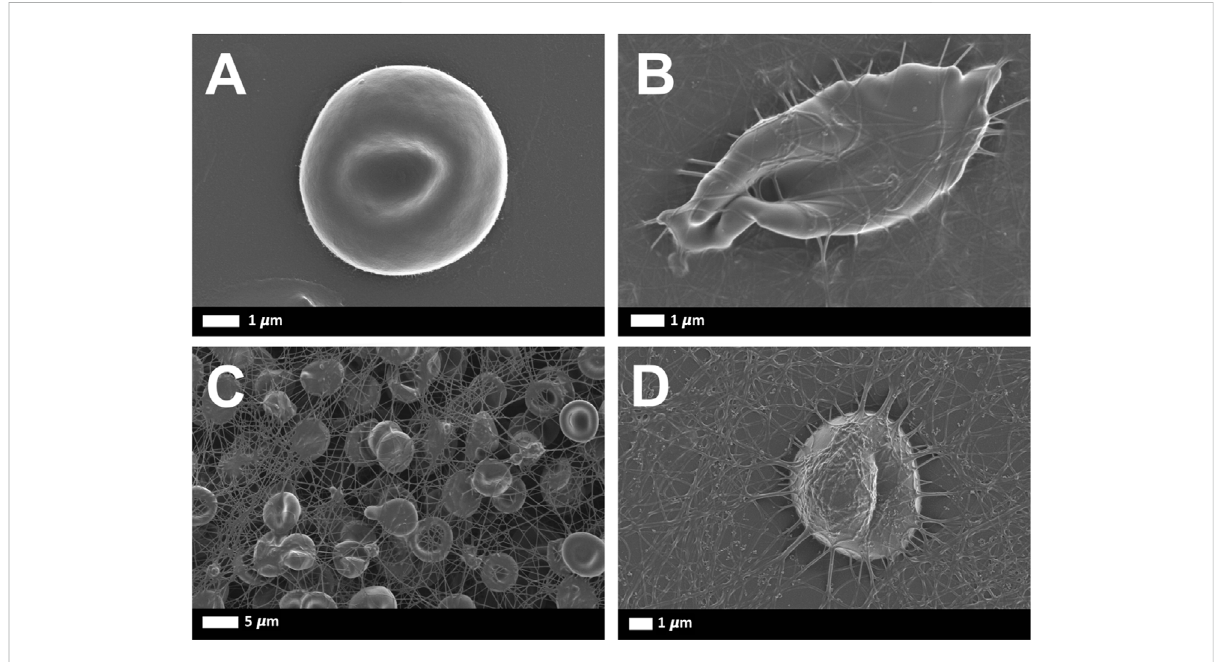
FIGURE 7 Representative scanningelectron microscopyimagesofRBCsfromhealthyandSCDsubjects: (A)